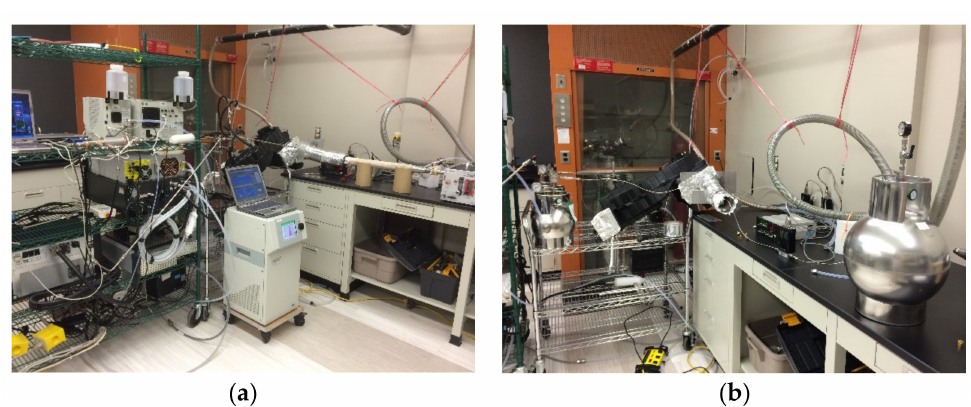
Figure A1. Photo on the left ( a ) shows the laboratory setup for the particle filtration efficiency experiment, while the photo on the right ( b ) shows the BTEX removal efficiency experiment setup.